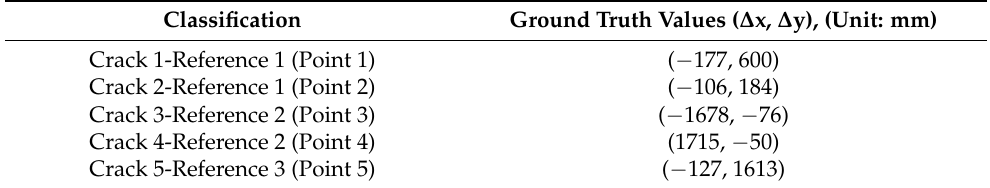
Table 4. Values of measured ground truth distance to cracks and reference object. (Location from reference point to remote points of